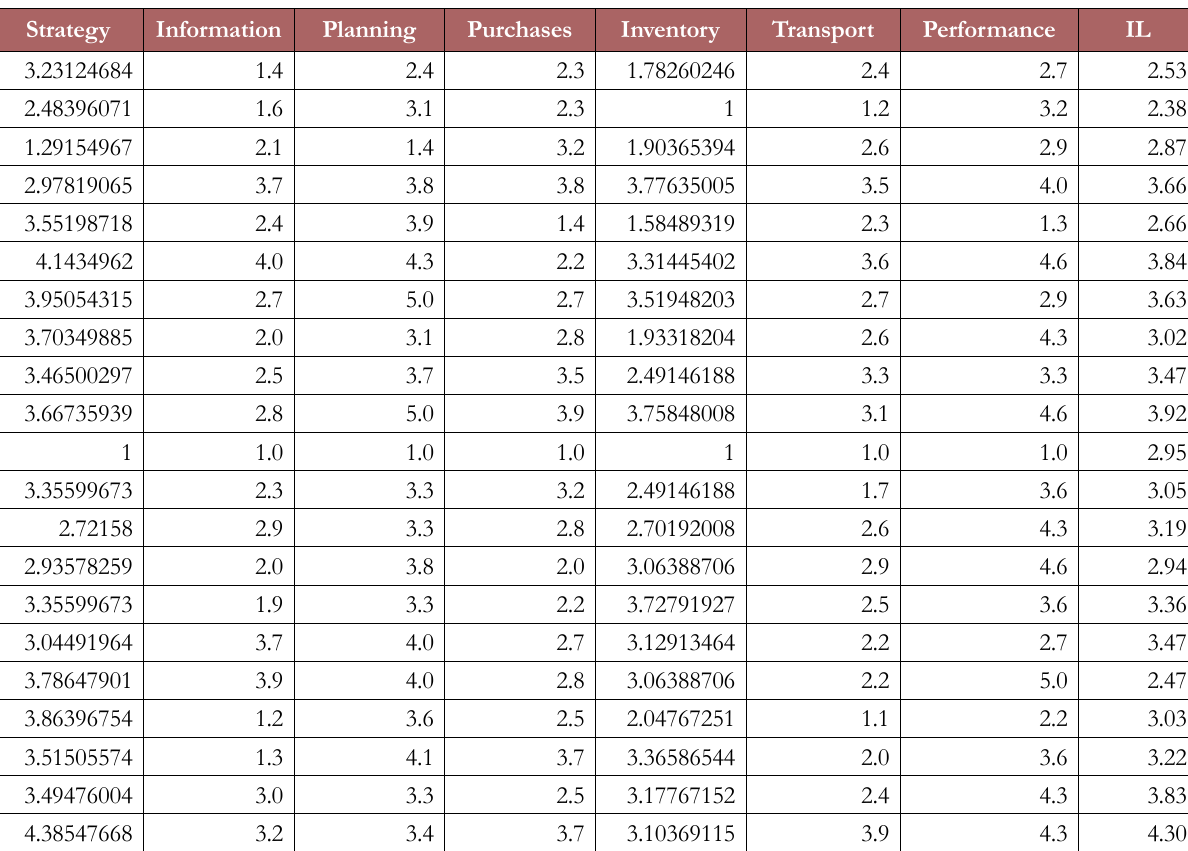
Table 2. Input and response variables with homogeneous